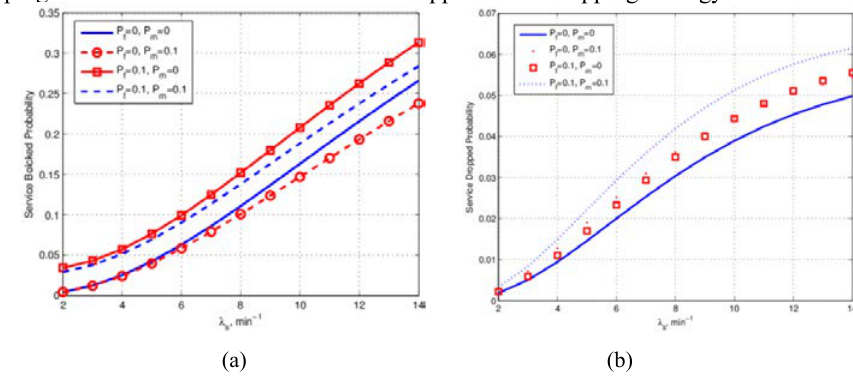
Fig. 5. (a) Service blocked probabilities for the OSA scheme with hopping under imperfect sensing; (b) Service dropped probabilities for the OSA scheme with hopping under imperfect